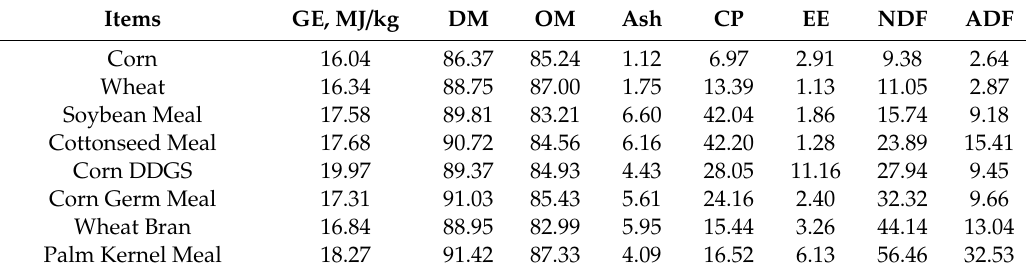
Table 1. Analyzed chemical compositions of the ingredients 1,2 (%, as-fed